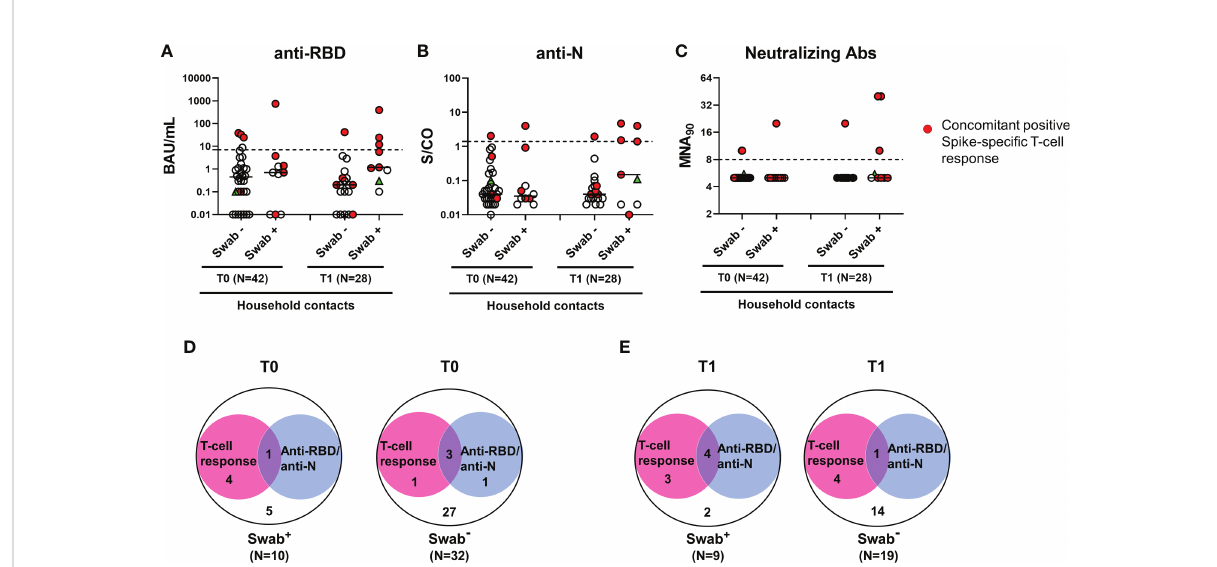
FIGURE 4 Antibody response in household contacts of COVID-19 cases. Evaluation of SARS-CoV-2-speci fi c anti-RBD (A) , anti-N (B) and neutralizing (C) antibodies in household contacts at T0 (n=42) and T1 (n=28). Anti-RBD, anti-N and neutralizing antibodies were evaluated in sera samples and reported as Binding Antibody Units (BAU)/mL (A) , Sample/Cutoff (S/CO) (B) , and reciprocal of dilution (MNA 90 ) (C) , respectively. Red dots indicate subjects with also a concomitant IFN- g speci fi c response as shown in the fi gure legend. Green triangle indicates the subject with positive swab only at T1. Dashed lines indicate the cut-off (anti-RBD: 7.1 BAU/mL; anti-N: 1.4 (S/CO); MNA 90 : 8). The black horizontal lines indicate the median. (D, E) Venn diagrams show the number of household contacts of COVID-19 cases at T0 and T1 with an IFN- g response and/or the serological one (anti-RBD and anti-N). Statistical analysis was performed using Fisher ’ s exact test with Bonferroni correction and p<0.01 was considered signi fi cant. IFN, interferon; COVID-19, COronaVIrus Disease 2019; RBD, receptor binding domain; N,